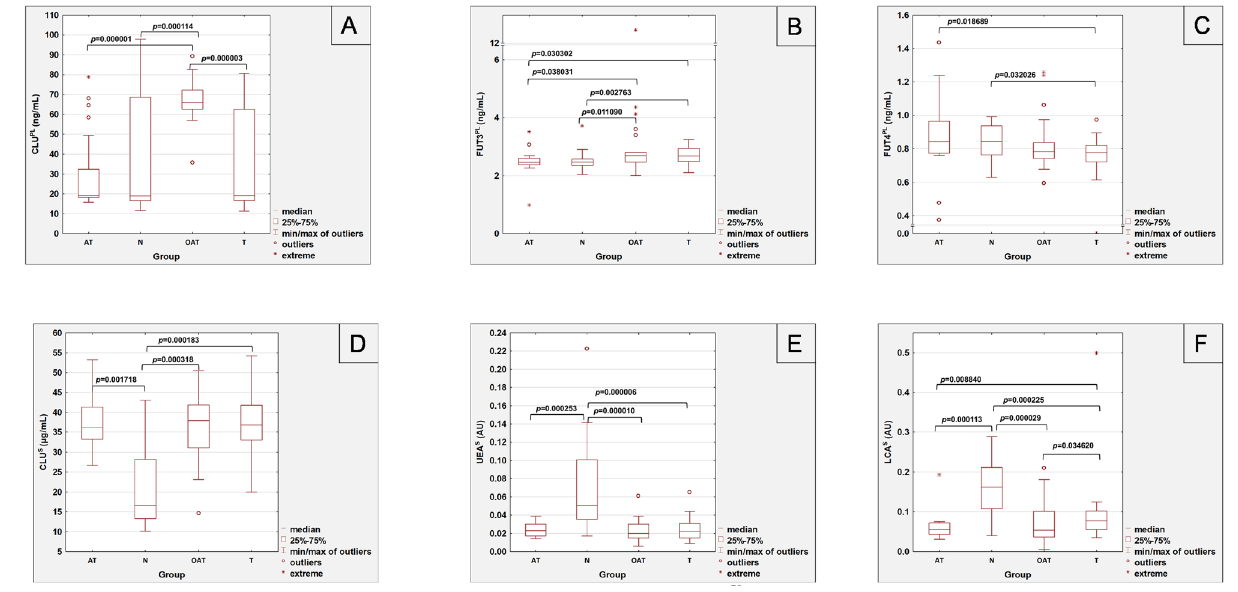
Figure 1. The values of seminal plasma ( A–C ) and serum ( D–F ) parameters measurements. CLU PL —seminal plasma CLU concentration; FUT3 PL —seminal plasma FUT3 concentration; FUT4 PL —seminal plasma FUT4 concentration; CLU S —serum CLU concentration; UEA S —relative reactivity of serum CLU glycans with Ulex europaeus agglutinin; LCA S - relative reactivity of serum CLU glycans with Lens culinaris agglutinin. A two- tailed p -Value of less than 0.05 was considered